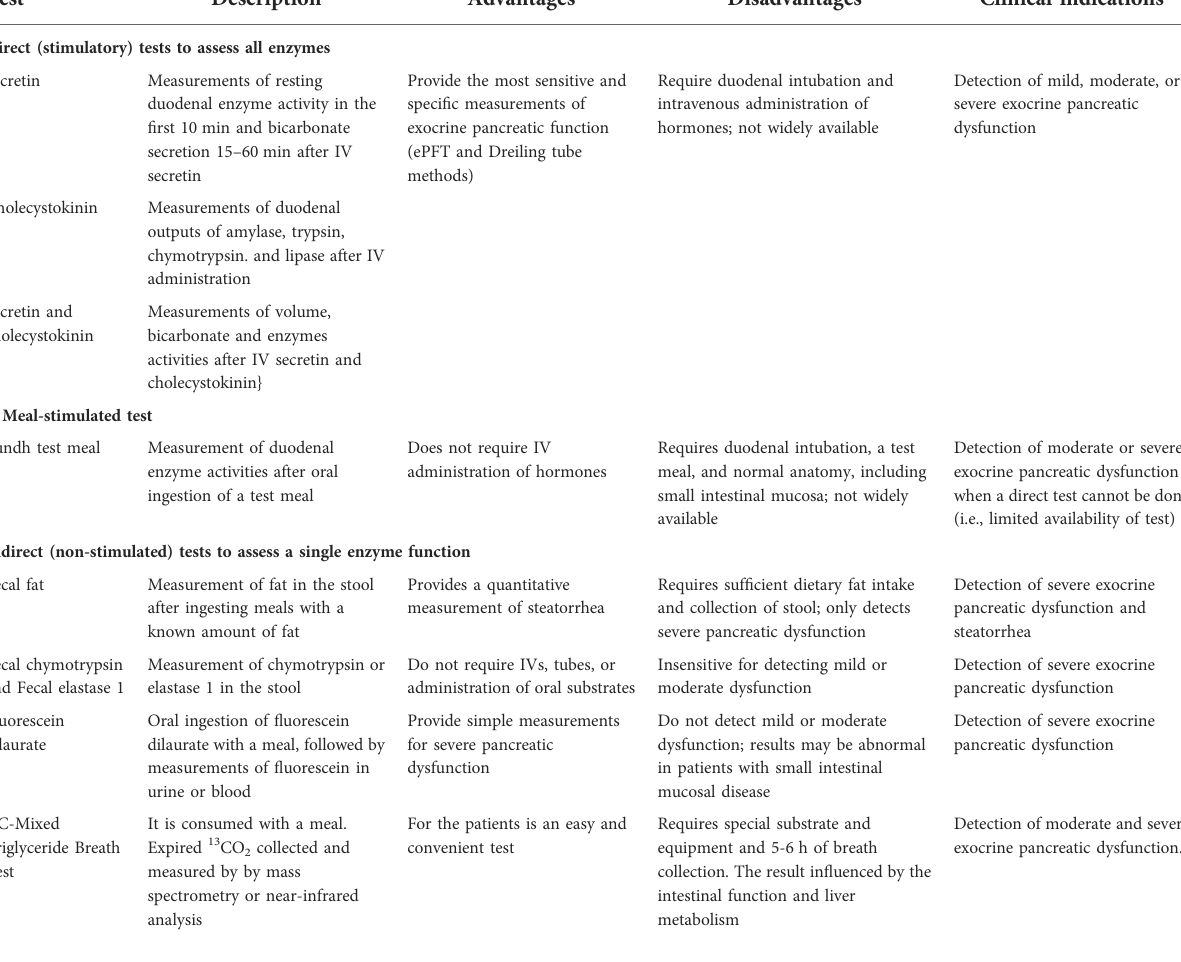
TABLE 3 Summary of the advantages, disadvantages, and clinical value of the different